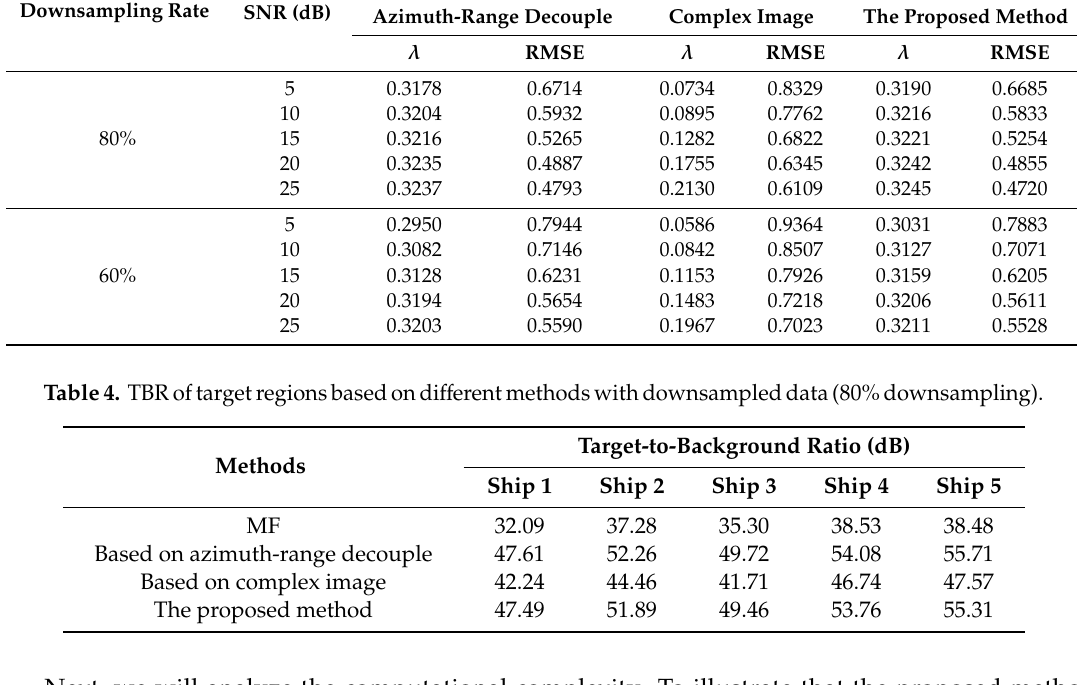
Table 3. The adaptive λ and RMSE for different SNR and downsampling rate.